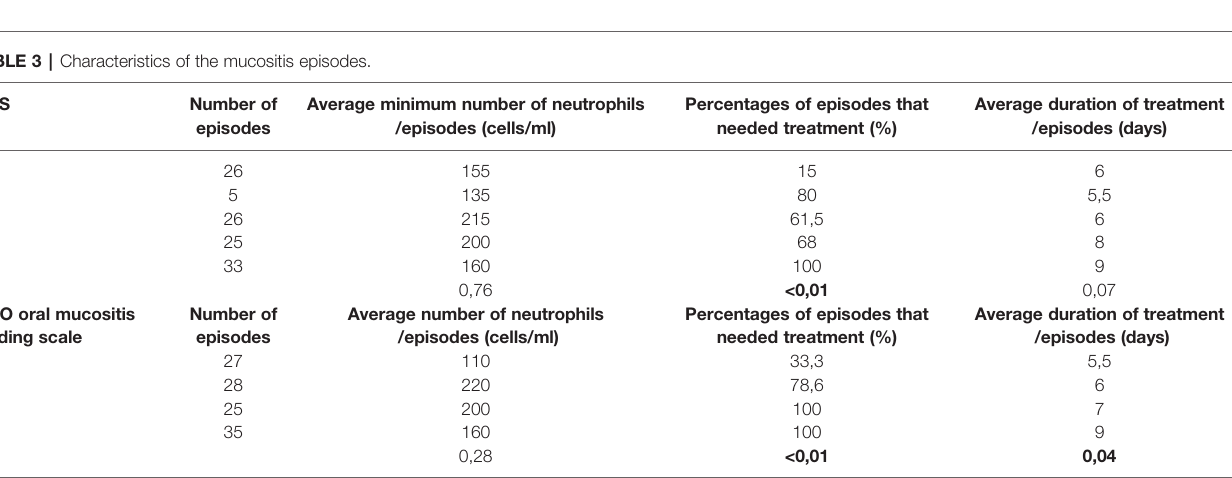
FIGURE 2 | Relationship between the pain expressed by patients through the WBS and WHO oral mucositis grading